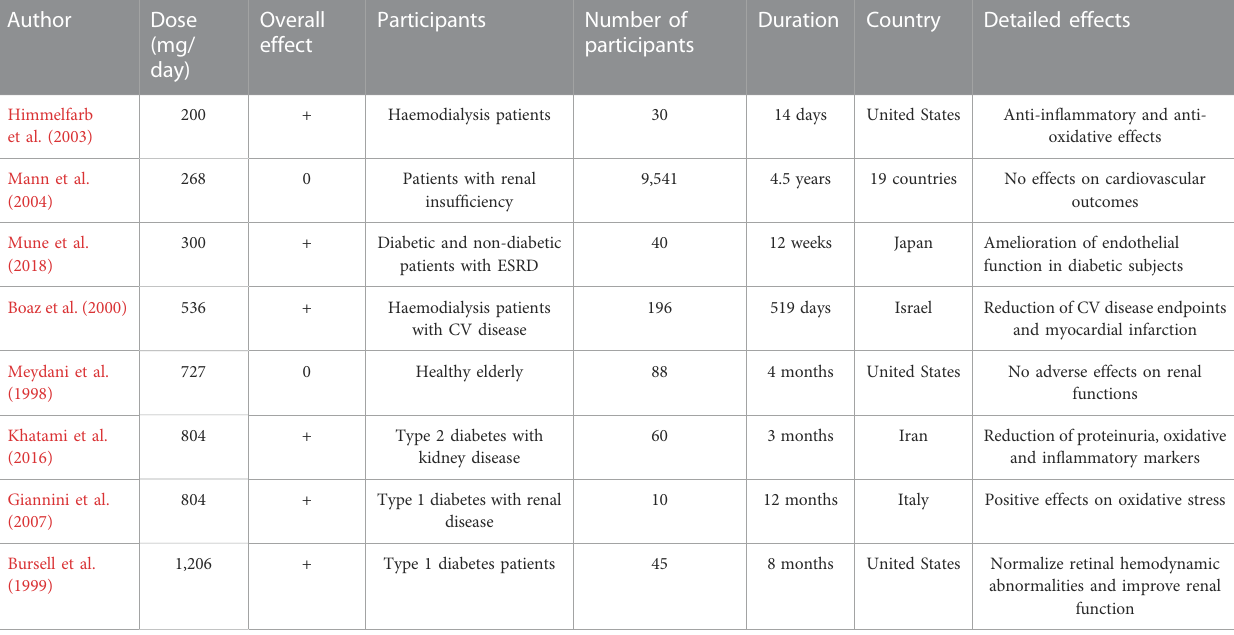
TABLE 3 Summary of human studies that reported effects of vitamin E supplementation on the kidneys.